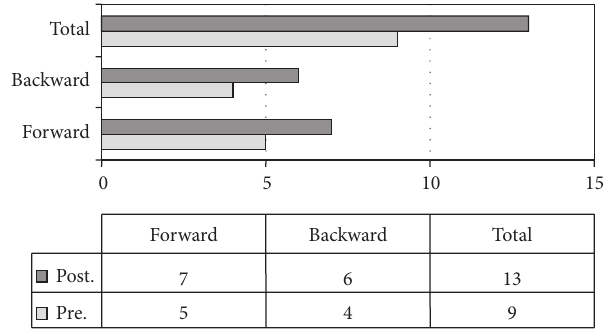
Figure 4: Digit span: number of forward and backward digits in baseline (pretreatment) and with MPH treatment